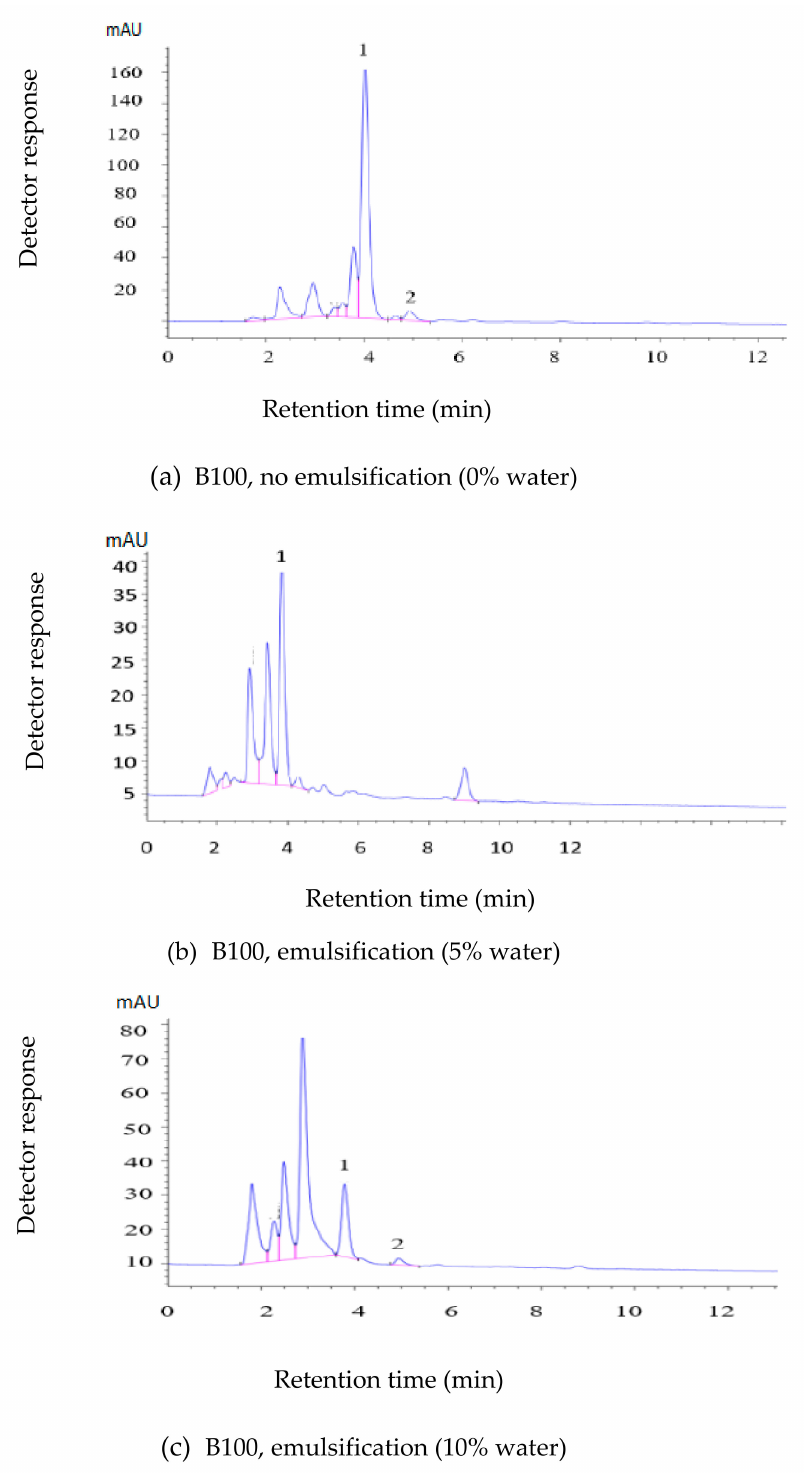
Figure 11. Liquid chromatogram of B100, ( a ) no emulsion, ( b ) 5% water, ( c ) 10% water. Figure 8 shows liquid chromatogram of B0: Figure 8a is without emulsion, Figure 8b with 5% water and Figure 8c with 10% water. Peak 1 is formaldehyde at the retention time of 4.070 min and peak 2 is acetaldehyde at 5.064 min. From the detector response (Y-axis), B0 with no emulsification has a formaldehyde peak, which is approximately 250 mAU. However, B0 with 5% water has a formaldehyde peak of only about 80 mAU; the formalde- hyde peak for B0 with 10% water is further reduced to about 35 mAU. The area